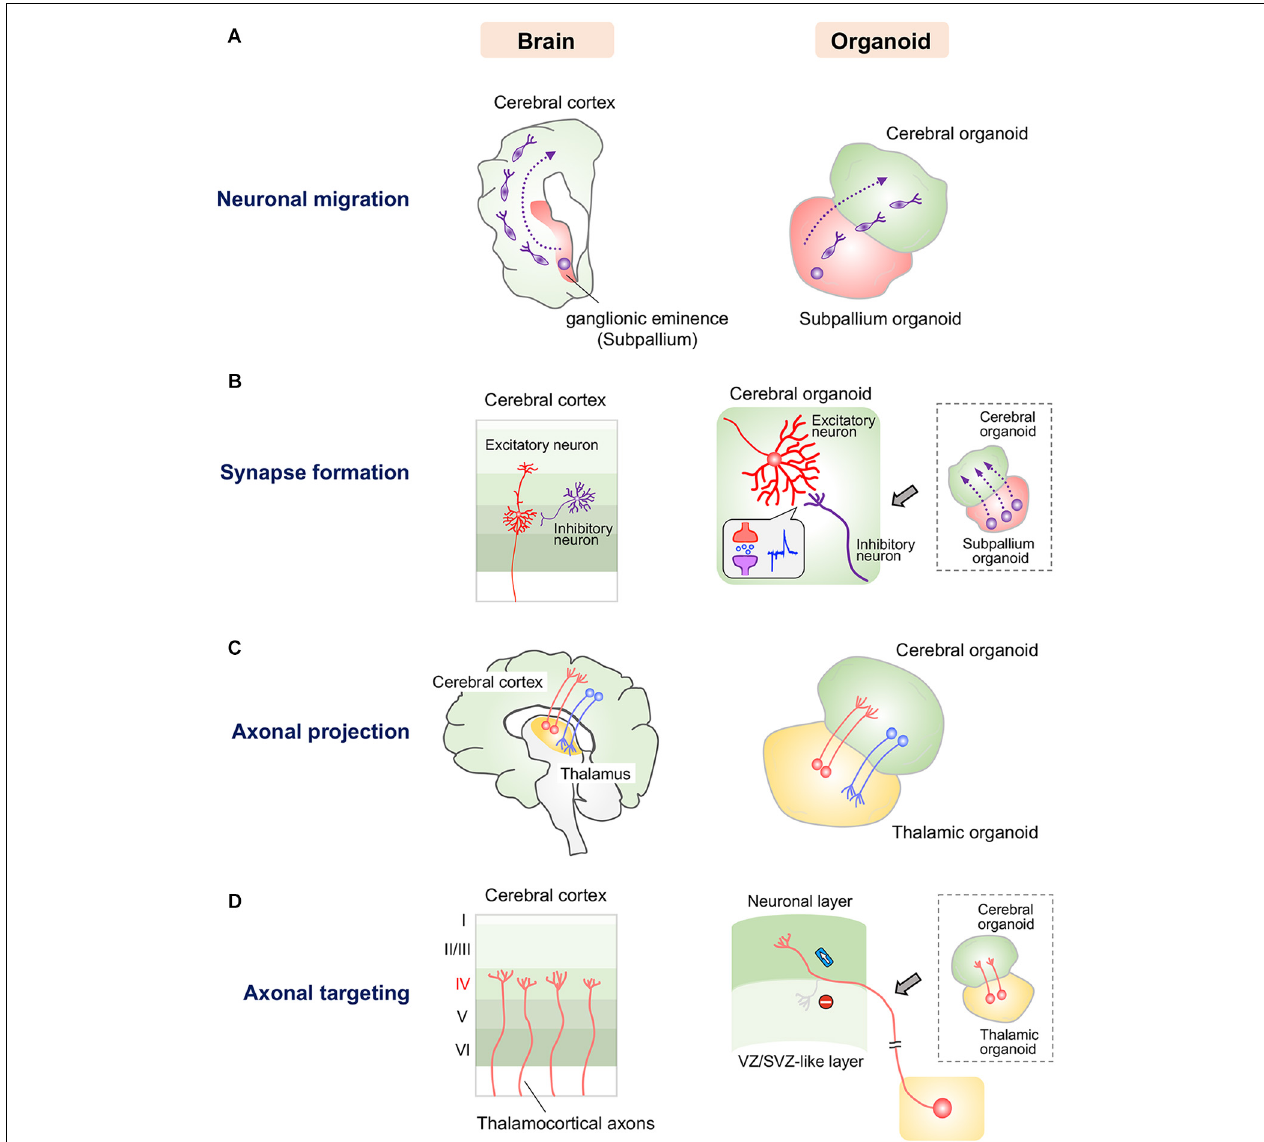
FIGURE 1 | Current approaches for modeling human neuronal circuit formation with fused brain organoids. (A) Left: Tangential migration of GABAergic interneurons from the ganglionic eminence to the cerebral cortex in the human brain. Right: GABAergic interneurons in subpallium organoids migrate into the cerebral organoid in fused organoids. (B) Left: Synapse formation between excitatory and inhibitory neurons in the human cerebral cortex. Right: GABAergic interneurons that migrate from subpallium organoids form functional synapses with excitatory neurons in cerebral organoids. (C) Left: Reciprocal axonal projection between the thalamus and cerebral cortex in the human brain. Right: Thalamic and cortical neurons reciprocally project axons into the other organoid in the fused system. (D) Left: Thalamocortical axons specifically innervate layer 4 of the somatosensory cortex. Right: Axons of thalamic organoids selectively innervate the neuronal layer but not the VZ/SVZ-like layer, in which neural stem/progenitor cells reside, in the fused cerebral organoid